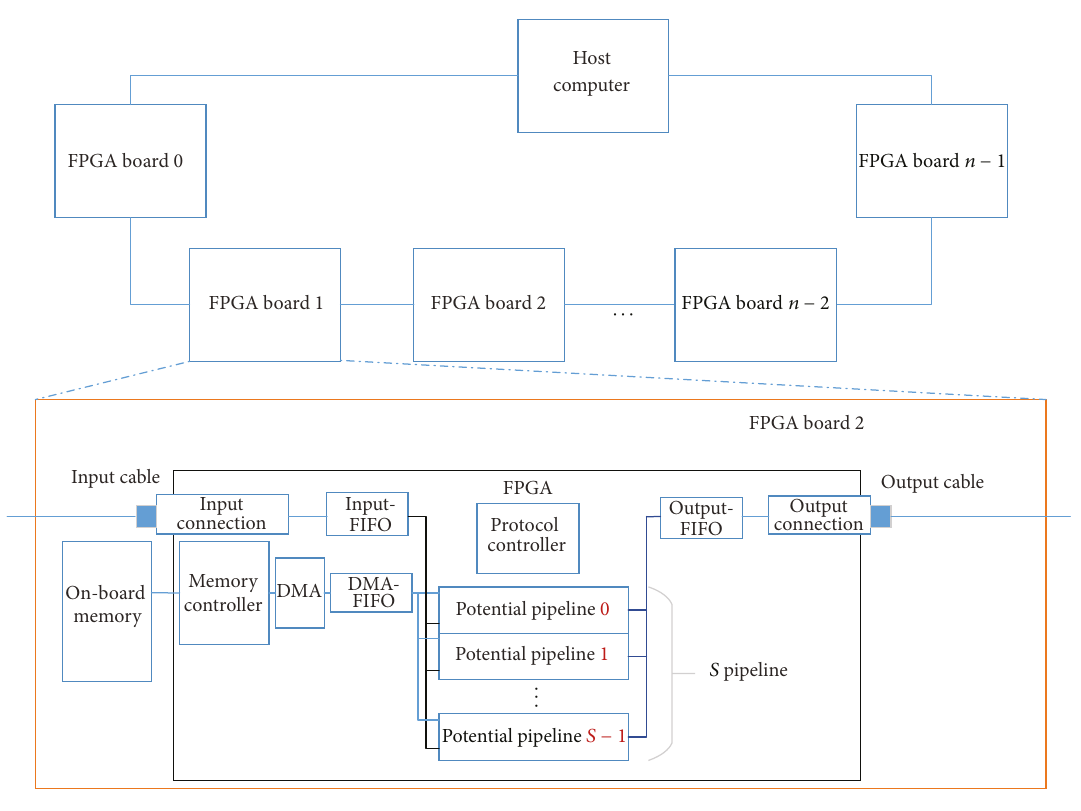
Figure 3: The architecture of RP-ring.